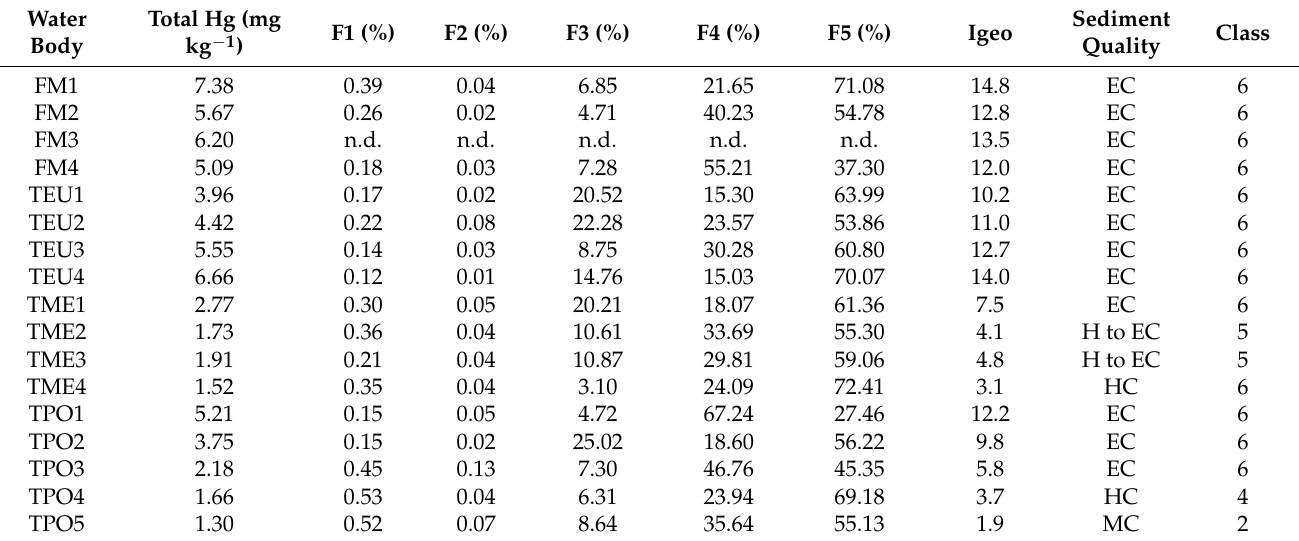
Table 1. Total Hg concentration, chemical fractionation, and calculated I geo [49] in surface sediments of the Marano and Grado Lagoon (n.d. = not